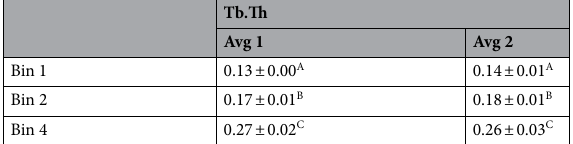
Table 4. Mean and standard deviation of Tb.Th values, according to frame averaging (Avg 1 or Avg 2) and data binning (Bin 1, Bin2, and Bin 4). Different uppercase letters among the rows in a column indicate significant differences, Bonferroni post-hoc test (p <